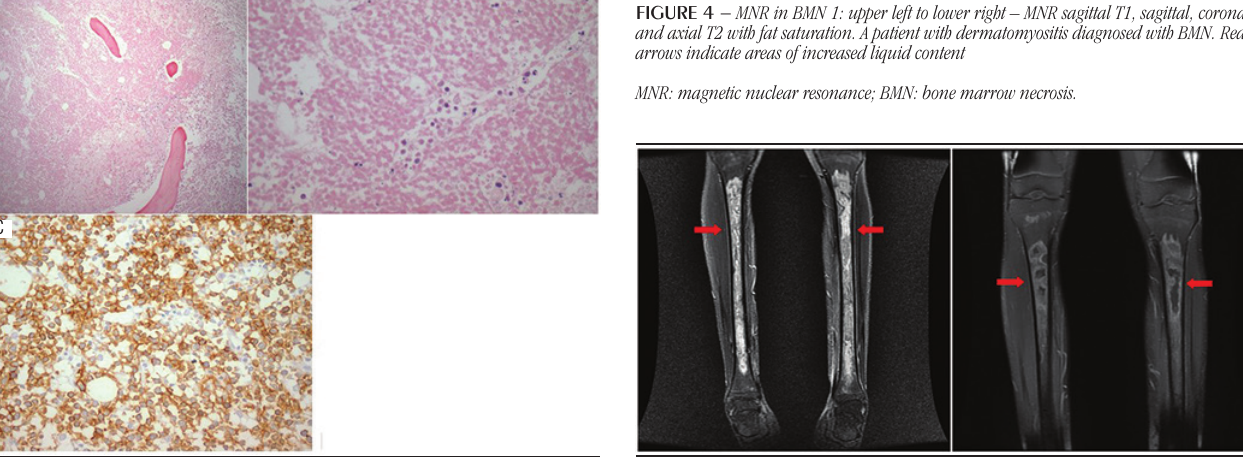
figurE 5 − MNR in BMN 2: left to right – MNR coronal STIR, axial T2 with fat saturation, T1 after contrast with fat saturation. Red arrows indicate areas of increased BM liquid MNR: magnetic nuclear resonance; BMN: bone marrow necrosis; STIR: short-TI inversion recovery; BM: bone